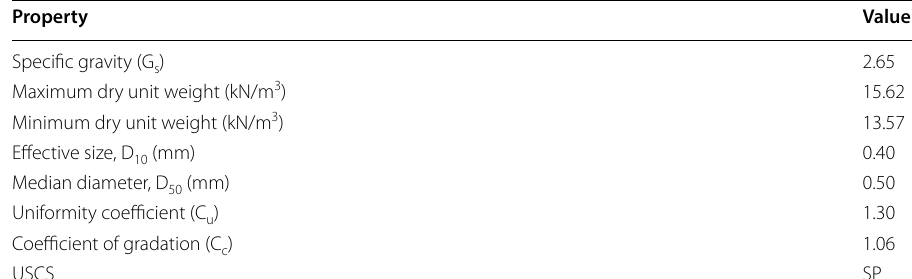
Table 1 Properties of Jumunjin sand Property